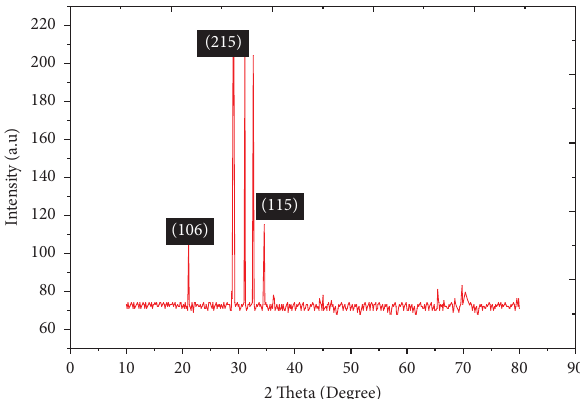
Figure 2: XRD pattern of FeO/Kevlar/epoxy based hybrid